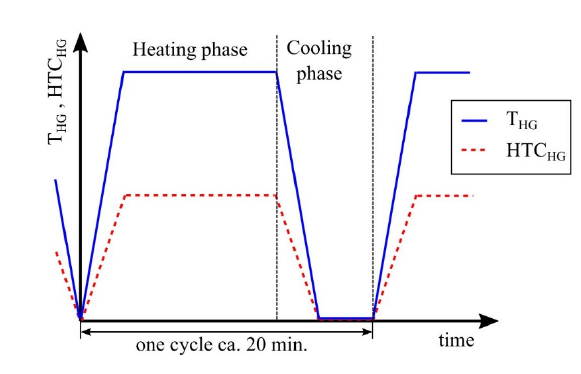
Figure 1. Qualitative sketch of hot gas temperature and heat transfer coefficient on hot gas